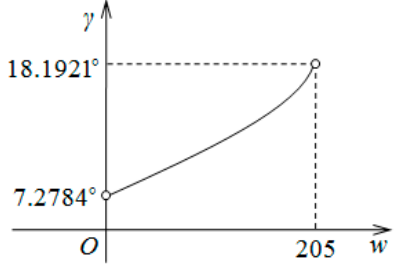
Figure 4. The relationship between the installation angle of the lug and its axial width. According to Equation (8), the relationship curve between the installation angle of the lug and the width “w” along the axis of the wheel can be drawn, as shown in Figure 4.